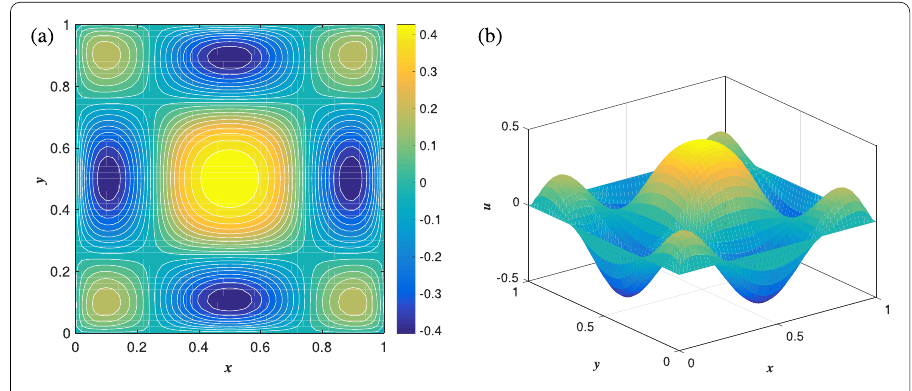
Fig. 6 Solution profile of 2D convection–diffusion equation, u ( x,y,t = 2) with input parameter = μ = 9 . μ 1 2